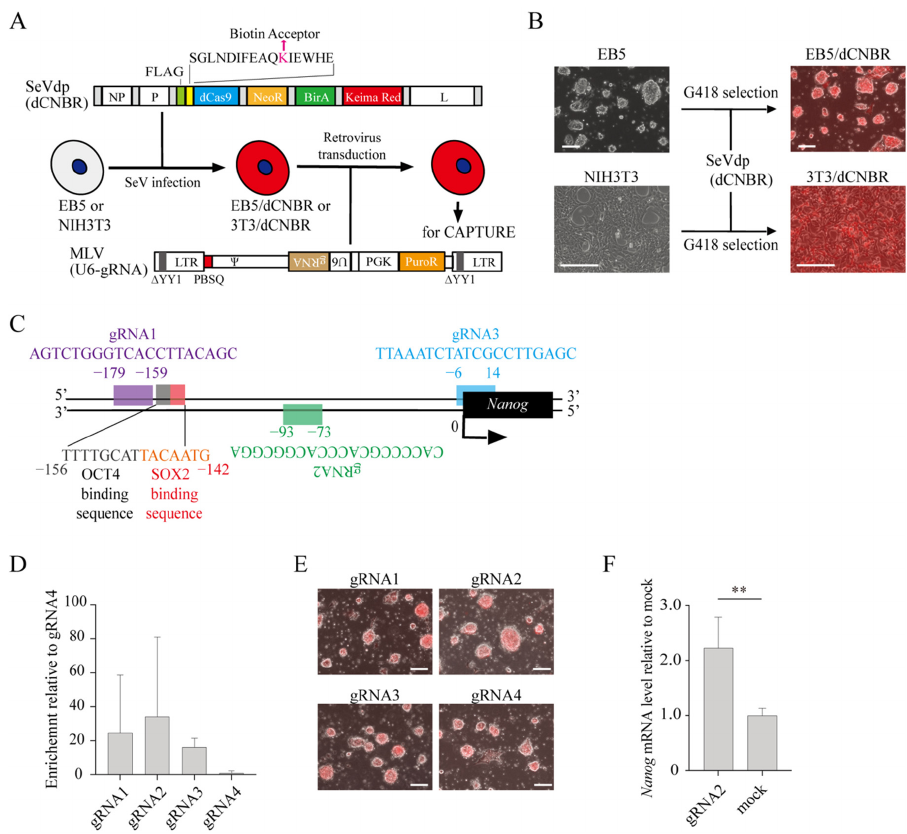
Figure 1. Generation of mouse embryonic stem cells (mESCs) for CAPTURE of the Nanog promoter. ( A ) Structure of vectors and experimental procedure for the CAPTURE method. SeVdp(dCNBR) vector expresses proteins for CAPTURE including dCas9, the neomycin resistant gene (NeoR), biotin ligase (BirA) and Keima-Red. dCas9 was fused with a FLAG-tag and biotin acceptor sequence at its N-terminus. After selection of SeVdp(dCNBR)-infected mESCs or NIH3T3 cells (EB5/dCNBR or 3T3/dCNBR, respectively), MLV(U6-gRNA) was transduced to express guide RNA (gRNA) as well as the puromycin resistant gene (PuroR). NP, P, and L; genes encoding Sendai virus NP, P, and L proteins, respectively. ∆ YY1 and PBSQ; mutations in the YY1-binding site and primer-binding site, respectively. LTR; long terminal repeat. ψ , packaging signal. U6; U6 promoter. PGK; PGK promoter. ( B ) Keima-Red expression from SeVdp(dCNBR). EB5 and NIH3T3 cells were infected with SeVdp(dCNBR) followed by selection with 800 µ g/mL and 1 mg/mL of G418 for 3 and 7 days, respectively. Scale bars, 200 µ m. ( C ) Positions of gRNA target sequences on each strand of the Nanog promoter. OCT4 and SOX2 binding motifs are also indicated. ( D ) Enrichment of the Nanog promoter DNA by CAPTURE with gRNAs. Chromatins were collected from EB5/dCNBR cells expressing the indicated gRNA, and fragmented chromatins were affinity-purified with streptavidin beads. Enrichment of the Nanog promoter in the purified chromatins was determined by qPCR. Enrichment was normalized by fold enrichment of gRNA4-transduced control. Data represent the mean ± SEM of three independent experiments. ( E ) Morphology of EB5/dCNBR cells transduced with gRNA-expressing retroviral vector. After transduction of MLV(U6-gRNA) expressing indicated gRNA, cells were selected by 2 µ g/mL puromycin for 2 days. Scale bars, 200 µ m. ( F ) Nanog expression in cells for CAPTURE of the Nanog promoter. Nanog mRNA levels in EB5/dCNBR cells with gRNA2 was determined 5 days after puromycin selection. mRNA level was normalized by that of mock-transduced EB5 cells. Data represent the mean ± SEM of three independent experiments. ** p <